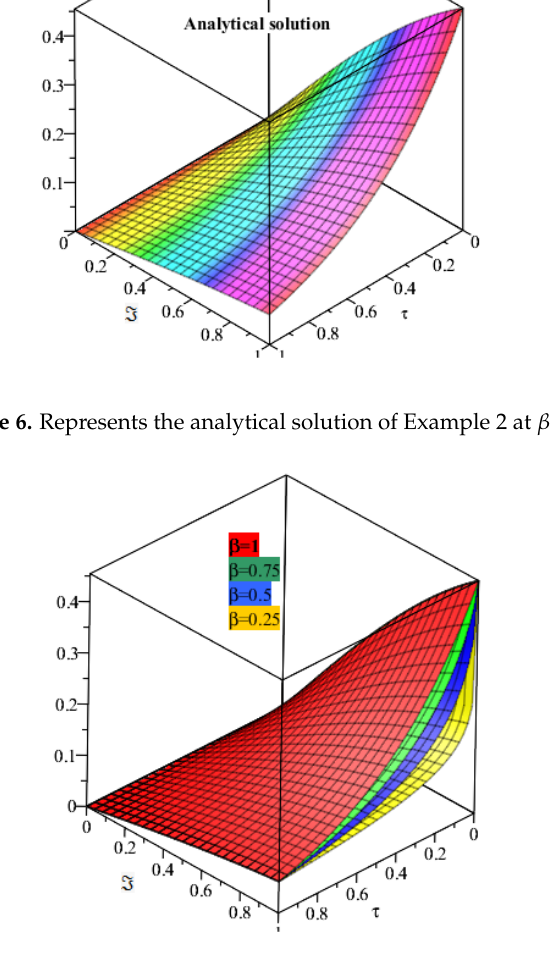
Figure 7. u ( (cid:61) , (cid:60) , τ ) Represents the solution at different fractional order of Example